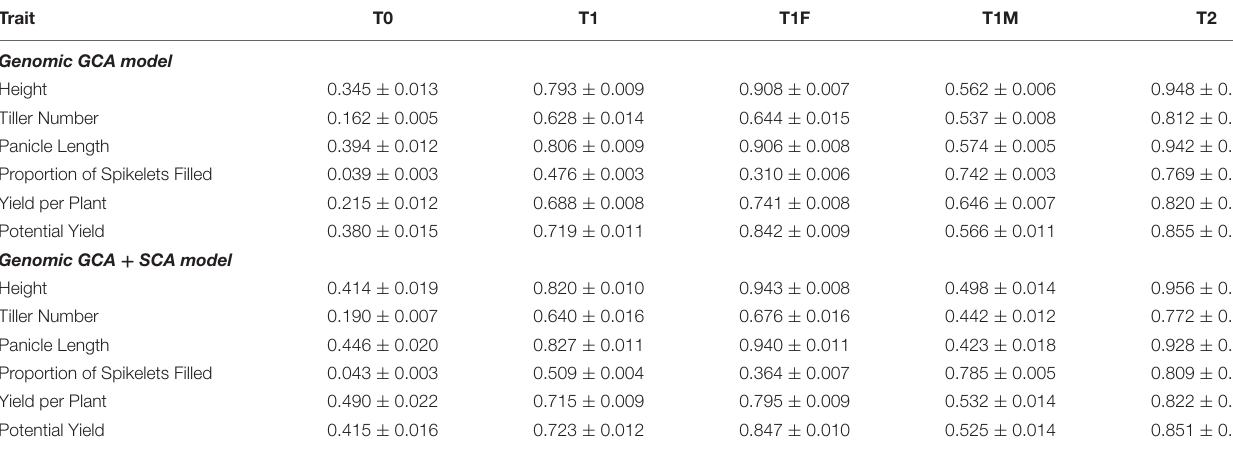
TABLE 3 | Mean prediction accuracies ± standard error thereof in cross-validation of the genomic prediction models for hybrids.